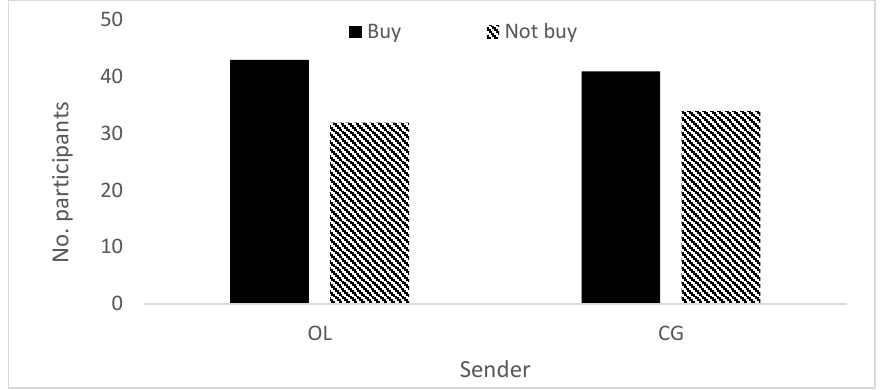
Figure 2. Consumer purchase behavior with or without OL eWOM. Valence. In total, 68% of the OL eWOM positive valence group bought the product while only 23% of the negative valence group did (Figure 3).